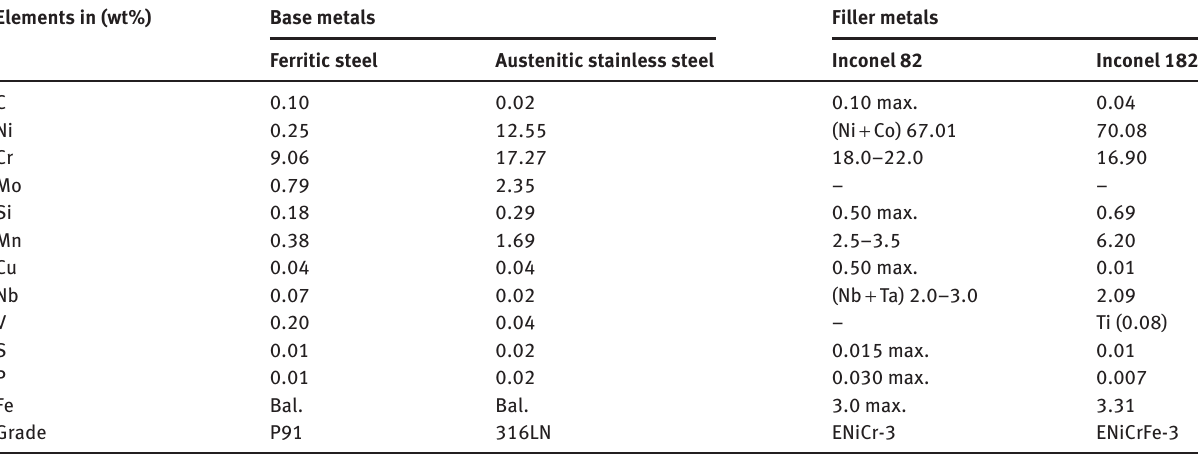
Table 1: Chemical compositions (in